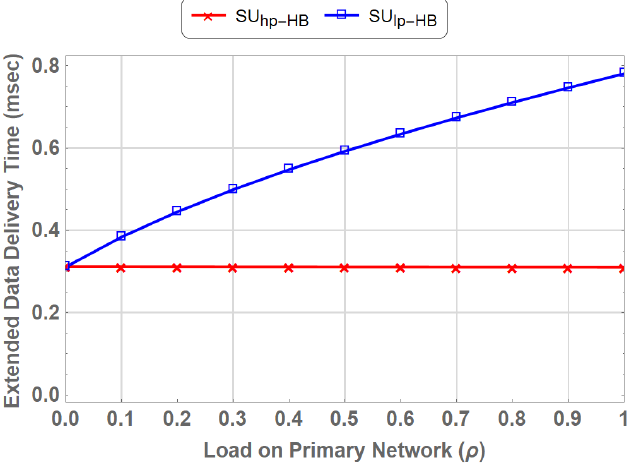
Figure 18. Comparison of Extended Data Delivery Time for Delay-Sensitive Traffic vs Delay-Tolerant Traffic in